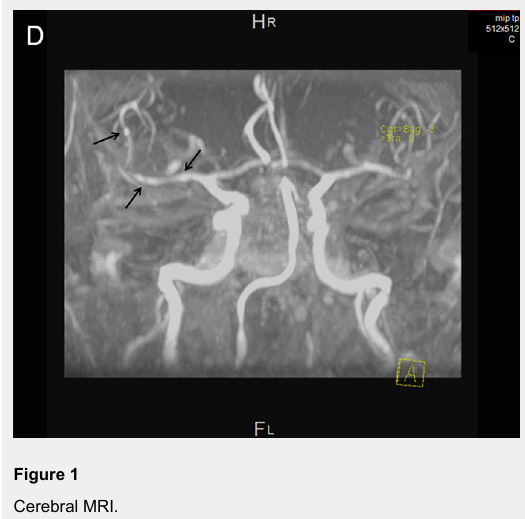
Cerebral MRI. A, B Axial diffusion-weighted images: Areas of ischaemic necrosis in the pons (A), and thalami and basal ganglia bilaterally (B). C Axial FLAIR image: Areas of ischaemia in the subcortical anterior and posterior territories. D MR angiography: Arrows highlight arterial irregularities suggestive of